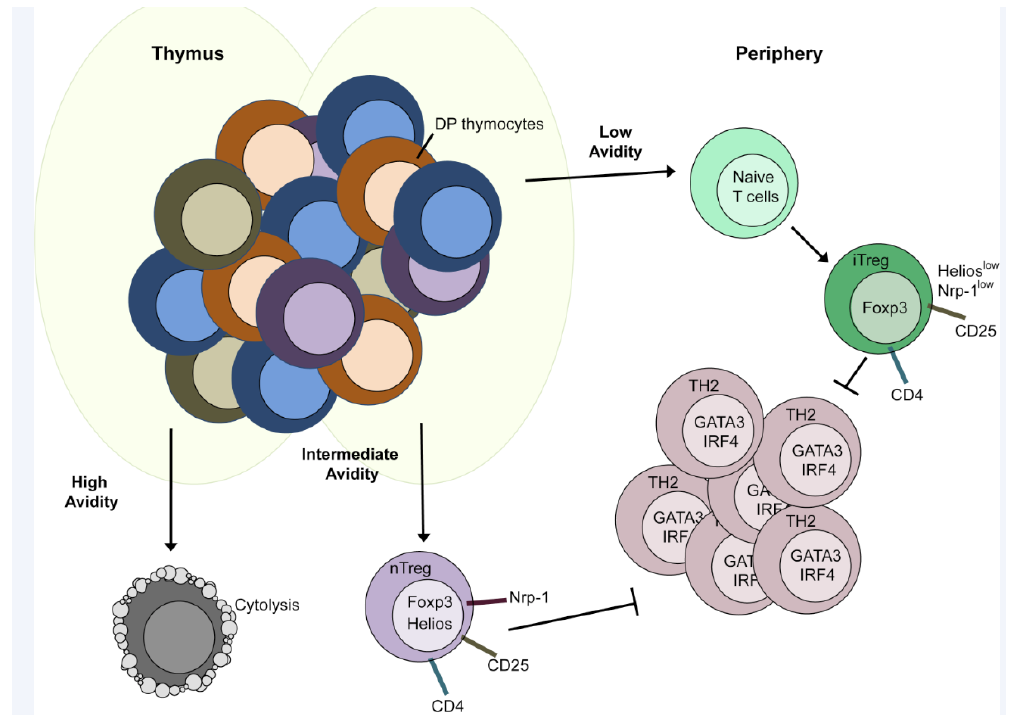
Figure 1. Generation of natural regulatory T (nTreg) and induced Treg (iTreg) cells. Schematic representation of nTreg and iTreg cell developmental pathways. Naturally occurring Treg cells develop upon intermediate-avidity interaction between developing thymocytes and self-antigen-presenting medullary epithelial cells. High-level expression of Neuropilin (Nrp-1) and Helios is maintained on nTreg cells after their migration from the thymus. Naïve conventional T cells that have undergone positive and negative selection in the thymus and have low avidity for self-antigens may develop into iTreg cells upon encountering antigens presented by tolerance-inducing antigen-presenting cells in specialized niches in the periphery. These cells express low levels of Helios or Nrp-1. Both nTreg and peripheral Treg cells are able to suppress CD4 + effector helper T 2 (TH2) cell responses. High-avidity T-cell receptor interaction in the thymus results in cytolytic T cells (negative selection). DP, double positive; IRF4, interferon gamma regulatory factor